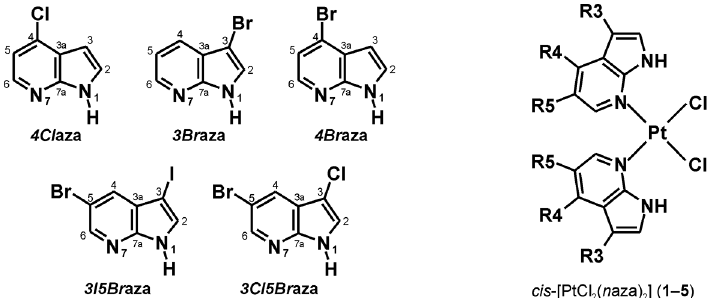
Fig 1. Structural formula of the studied complexes cis -[PtCl 2 ( n aza) 2 ] (1 – 5) and 7-azaindole derivatives used for their preparation. The general structural formulas of used 4-chloro-7-azaindole ( 4Cl aza; complex